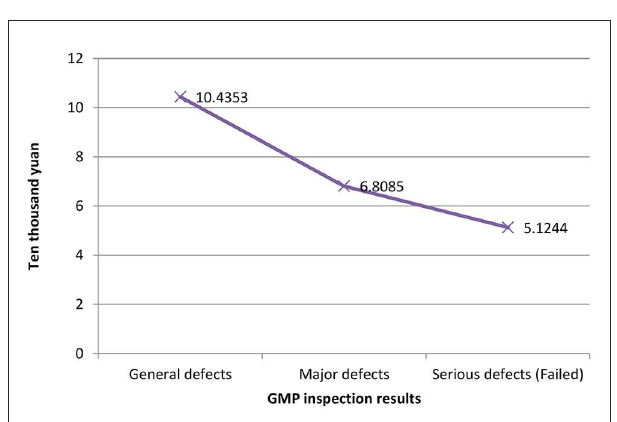
FIGURE2 Years of quality authorized staff in the company and GMP inspection